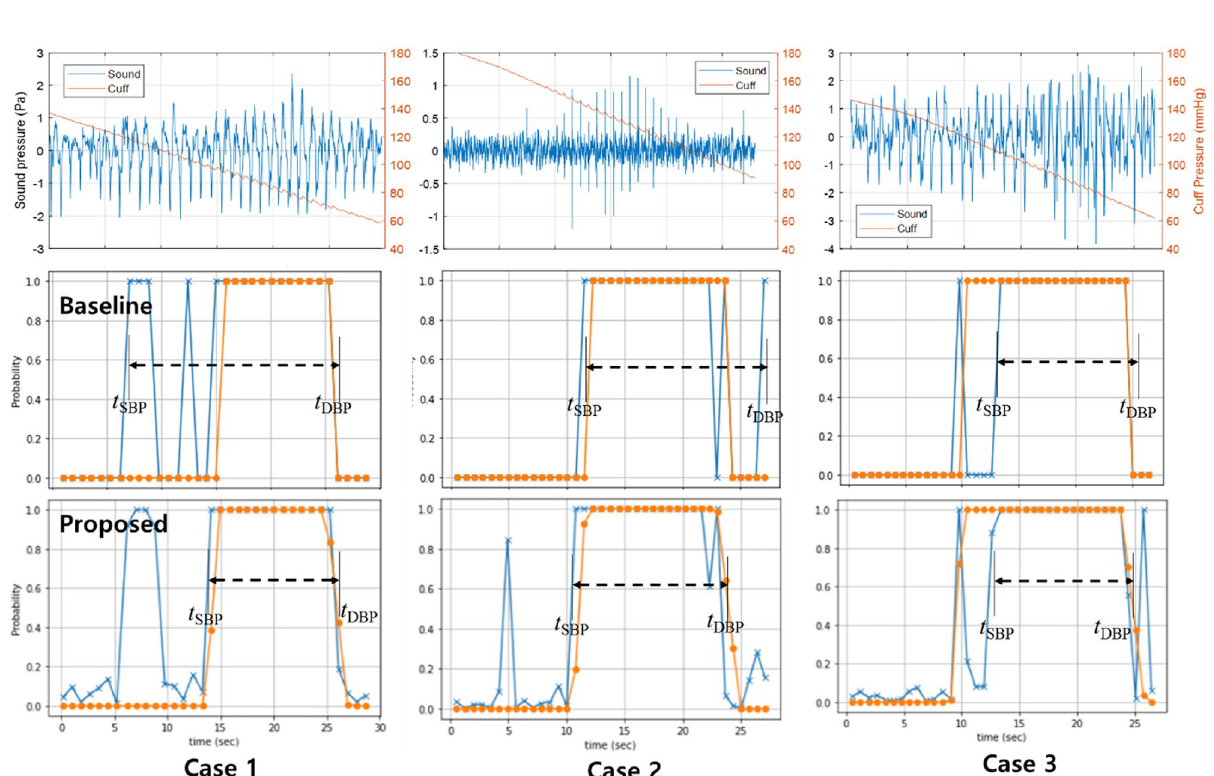
Figure 10. Sound signal (top) and predicted probability with the baseline (middle) and the proposed model (bottom) in three noisy